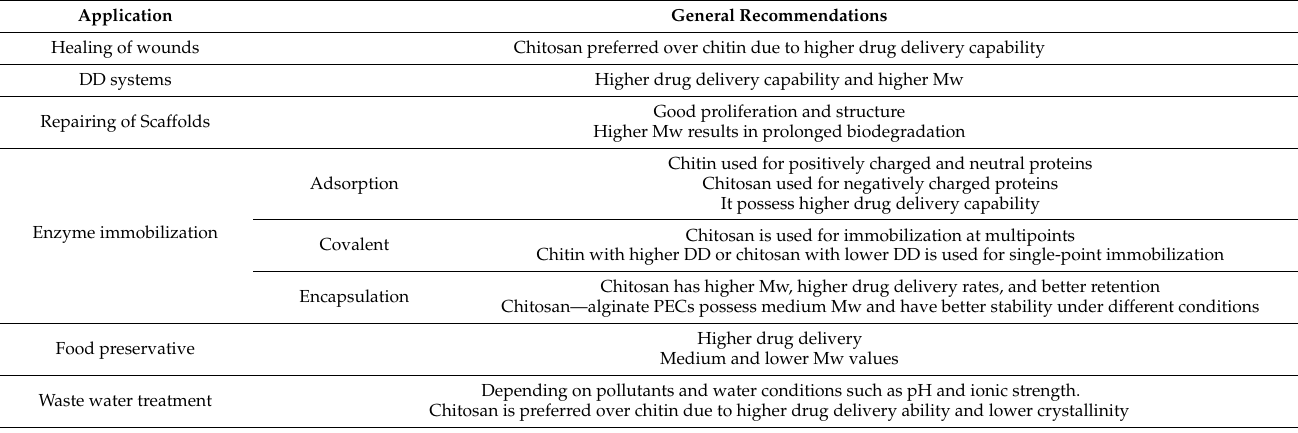
Figure 30. Process involved in making SPM–chitosan hydrogels. Reprinted from [93]. Copyright 2021 with permission from the American Chemical Society. Table 4. Various applications of chitin and chitosan and general recommendations